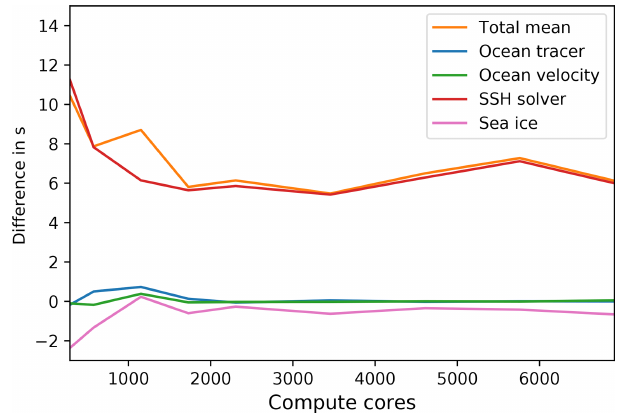
Figure B2. Difference between runtimes of the experiment with warm start and larger time step and the experiment with cold start and smaller time step.